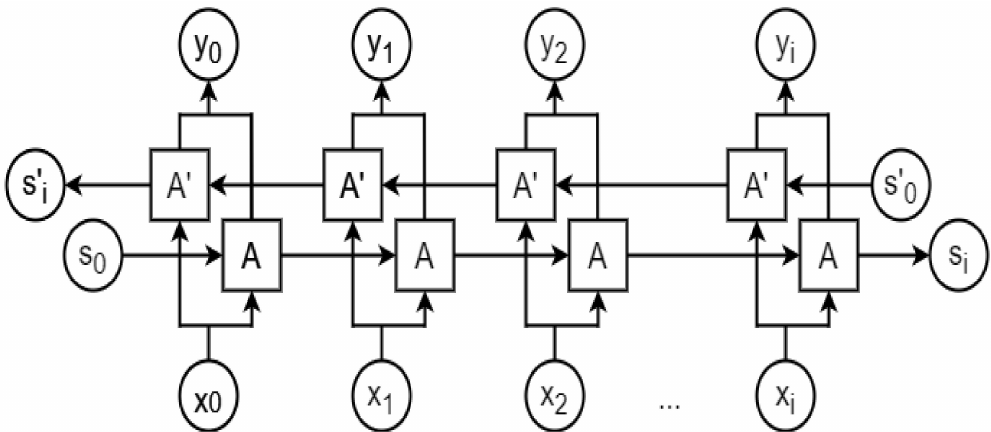
Figure 10. A bidirectional LSTM (BLTSM) architecture. A and A’ represent an LSTM cell propagating data dependency in forward and reverse directions, respectively. x t and y t are input and output at timestep t from each LSTM cell, respectively. S 0 and S’ 0 denote the initial states, whereas S i and S’ i denote the final states.